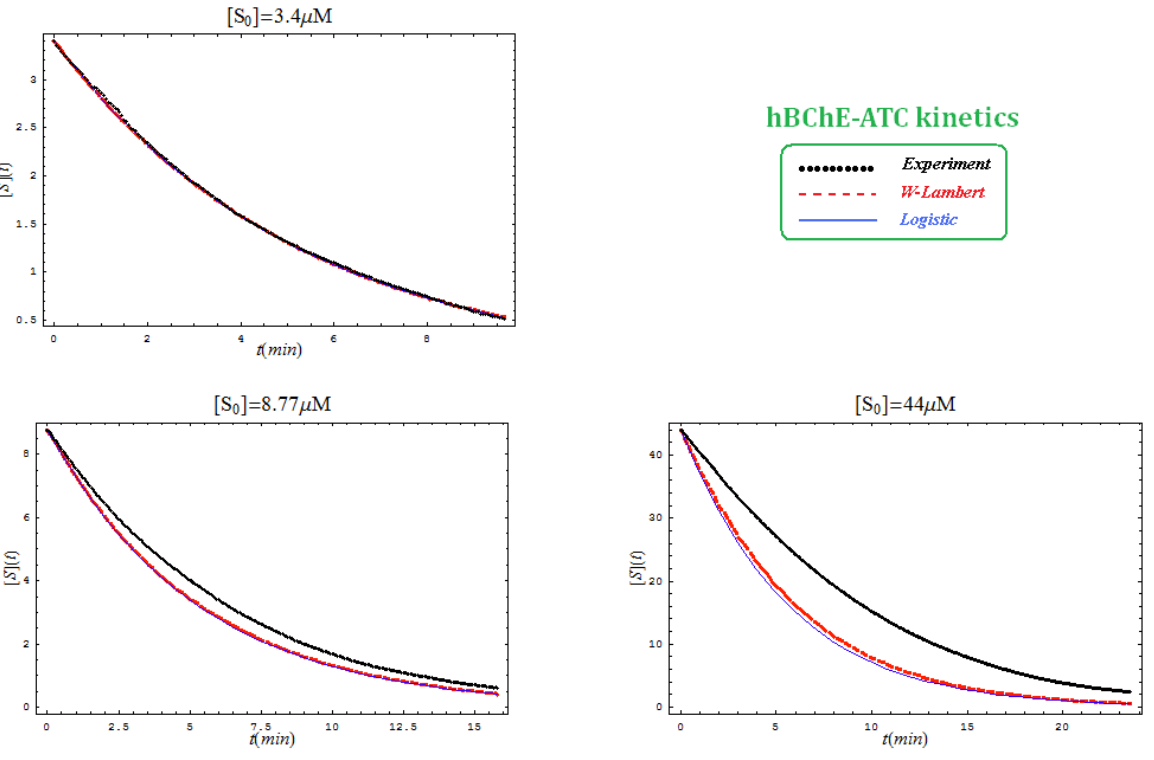
Figure 4. The same type of plots as in Figure 3, here for hBChE-ATC kinetics and parameters K = 160 µM; K = 8,700 µM; V = 31.0 µM/min; b = S SS max